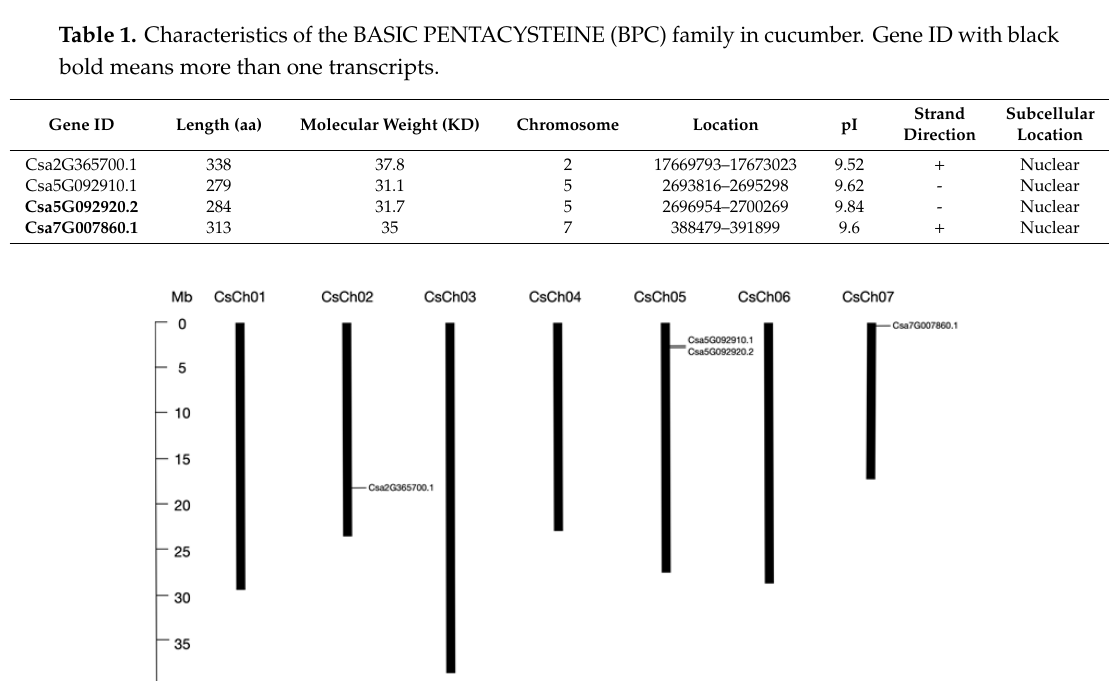
Table 1. Characteristics of the BASIC PENTACYSTEINE (BPC) family in cucumber. Gene ID with black bold means more than one transcripts.